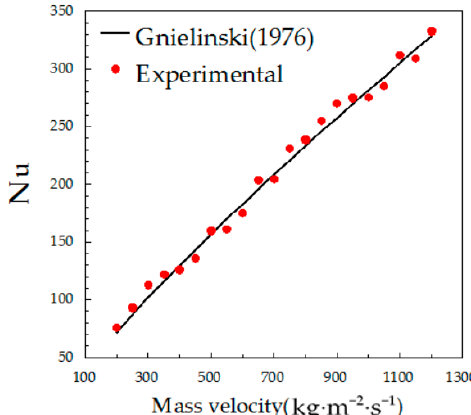
Figure 4. Comparisons of heat transfer rate between refrigerant/water-testing experimental value and theoretical value for a single-phase flow.